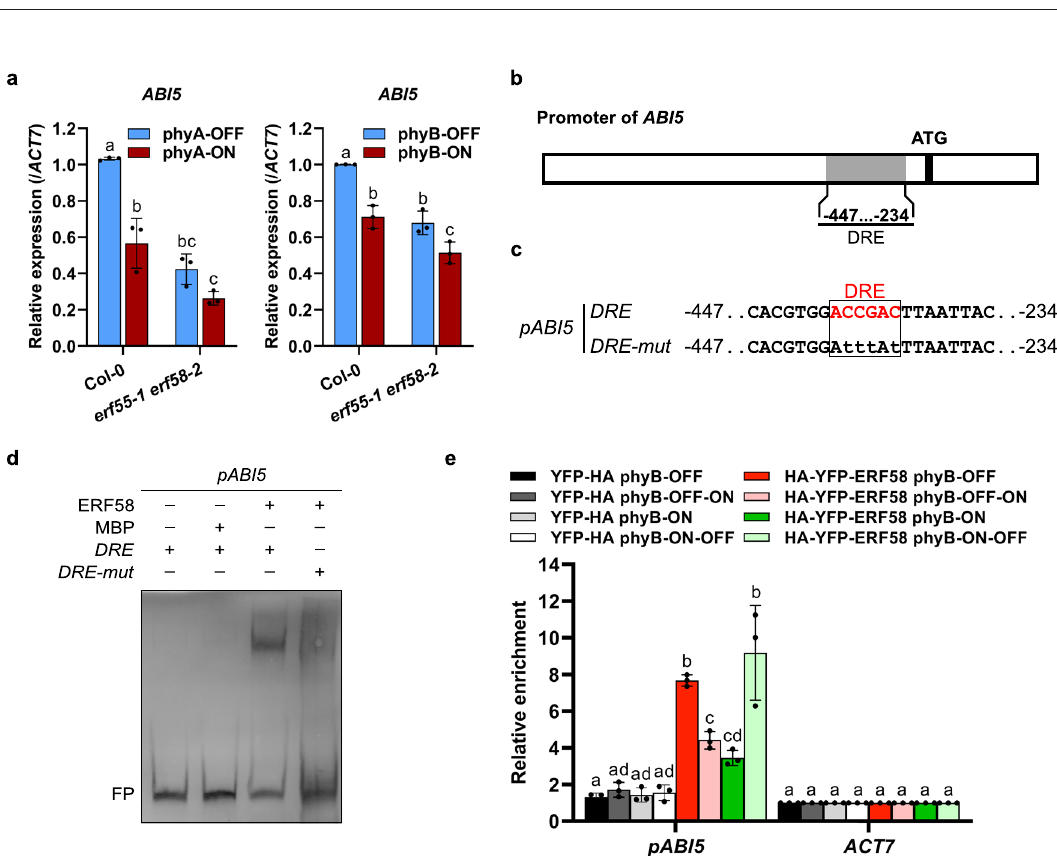
Fig. 6 ERF55 and ERF58 upregulate ABI5 expression. a RT-qPCR analysis of ABI5 expression levels in Col-0 and erf55-1 erf58-2 seeds germinating under phyA-ON/OFF or phyB-ON/OFF conditions. Light conditions are described in Supplementary Fig. 6a, b. ACT7 was used as an internal control. Values show means of three replicates ±SD. b , c Schematic representation of the ABI5 promoter. The promoter fragment used for EMSA is shown in c . d EMSA. Biotin- labelled ABI5 − 234 … − 447 promoter fragments containing a wild-type or mutated DRE motif were incubated with MBP-ERF58 or MBP alone (negative control). Samples were analysed by native PAGE. The gel was blotted onto a nylon membrane and signals were detected by streptavidin-coupled horseradish peroxidase and ECL. FP, free probe. The experiment was repeated fi ve times with similar results. Data for ERF55 are shown in Supplementary Fig. 13b. e ChIP-qPCR. Germinating seeds of Col-0 p35S:HA-YFP-ERF58 (line 21C) and Col-0 p35S:YFP-HA (negative control) were subject to light treatments as described in Fig. 4a. Chromatin was isolated and HA-YFP-ERF58 bound DNA fragments were puri fi ed using α -GFP coupled magnetic beads. qPCR and speci fi c primers were used to detect the ABI5 − 234 … − 447 promoter fragment in the eluate fraction. ACT7 was used for normalisation. Values show enrichment of the ABI5 promoter fragment in the eluate fraction compared to the input fraction and are means of three replicates ±SD. a , e Different letters indicate signi fi cant differences as determined by two-way ANOVA followed by post-hoc Tukey ’ s HSD test. a p < 0.05. e p <